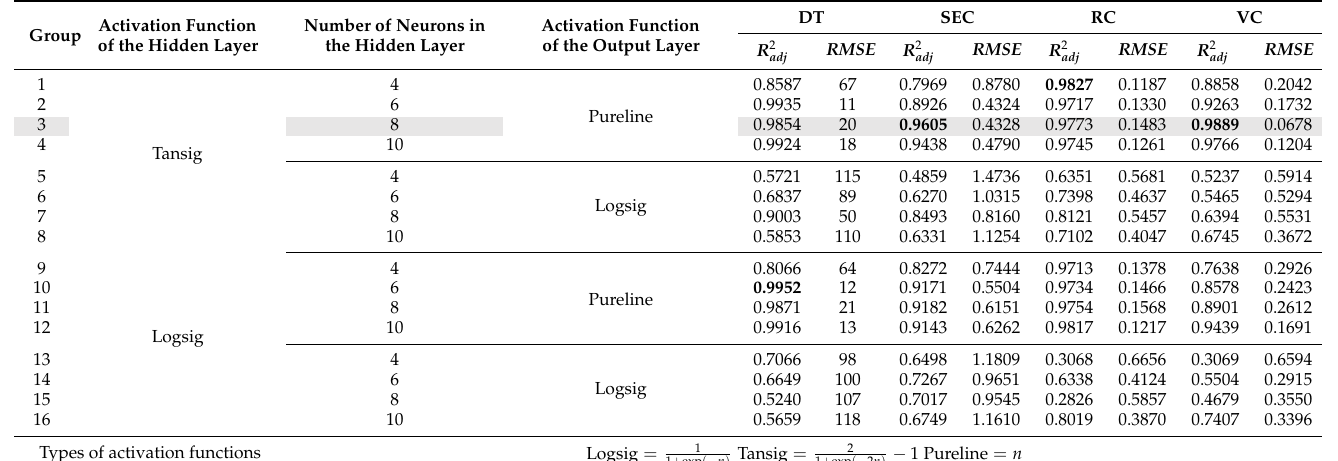
Table 2. Test of different ANN structures and activation functions (shaded groups contain the highest R 2 for at least one response variable; bold font indicates the best solution).